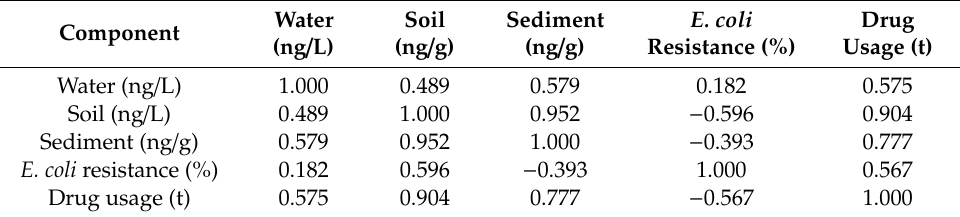
Table 2. The correlation matrix of relevant antibiotic data in Chongqing, 2013.